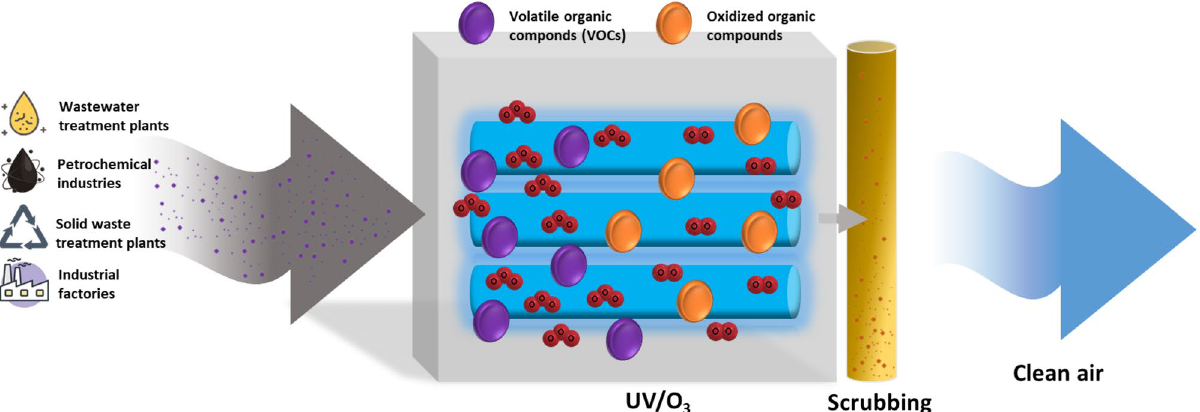
Figure 5. Schematic representation of the advanced oxidation process coupled with wet scrubbing for the VOCs removal from industrial and environmental facilities.